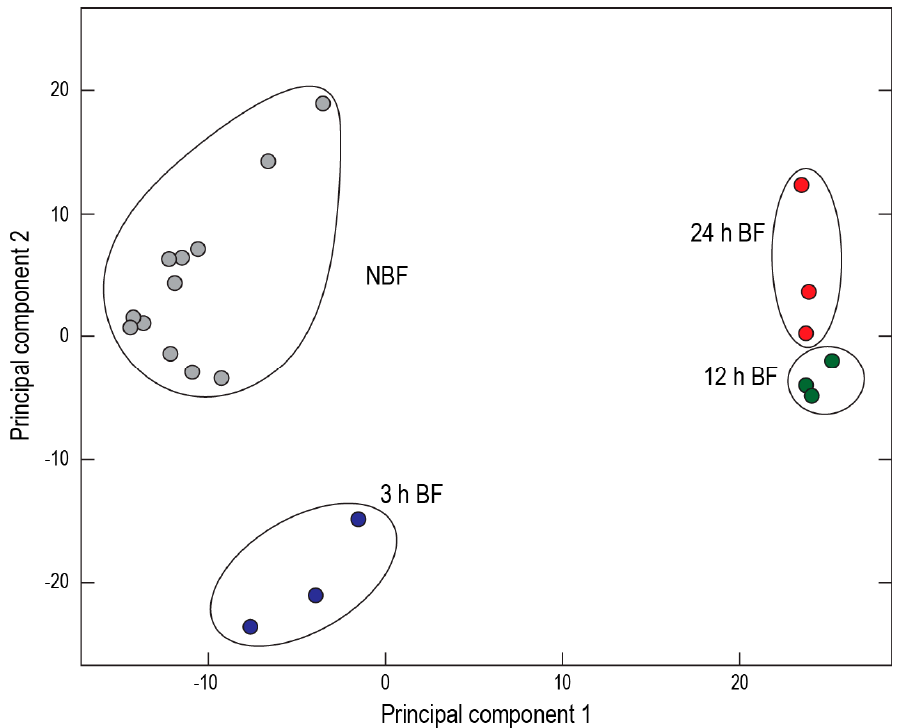
Figure 8. Principal component analysis of transcript expression in Malpighian tubules from non-blood fed (NBF) and blood-fed (BF) mosquitoes ( Ae. albopictus ). Each circle represents a sequenced cDNA library